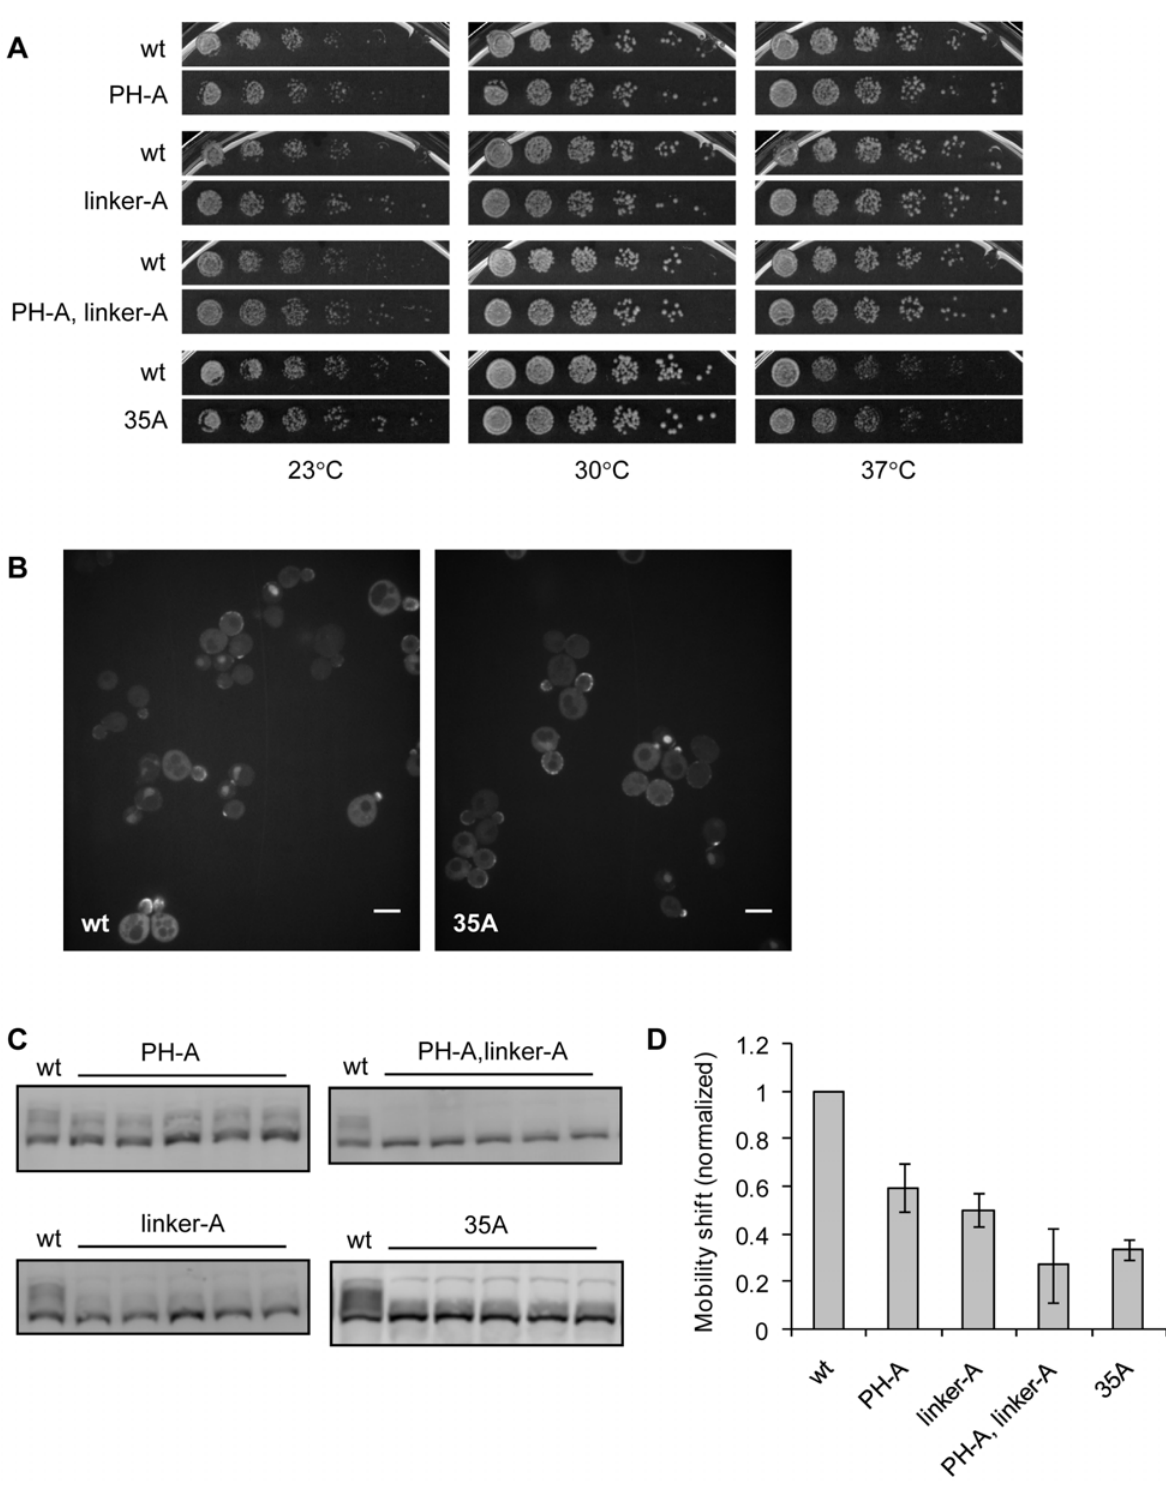
Figure 5. Mutations of non-consensus sites also do not affect cell growth or Cdc24 localization, but they further decrease mobility shift of Cdc24. A. Serial dilutions of wild type control (wt, RLY2530), cdc24 PH-A (RLY3391), cdc24 linker-A (RLY3393), cdc24 PH-A,linker-A (RLY3390), and cdc24 35A (RLY3461) were spotted onto YEPD agar plates and grown for 2 d at 23 u C, 30 u C, and 37 u C, or 7 d at 16 u C (not shown). Mutant strains are shown alongside a wild type control that was spotted on the same plate. Only strains relevant to this experiment are shown in this figure. See Materials and Methods for more information. B. Confocal images of strains containing Cdc24-GFP (RLY3437) and Cdc24 35A -GFP (RLY3468). Confocal images of other mutants are shown in Figure S2B. C. Mobility shift of Cdc24 band. Whole cell extracts were prepared from asynchronous cultures. Blots were probed with rabbit anti-Cdc24 antiserum. Faint band just above smear is a cross-reacting protein (*). D. Quantification of mobility shift, calculated, normalized, and displayed as in Figure 2B.